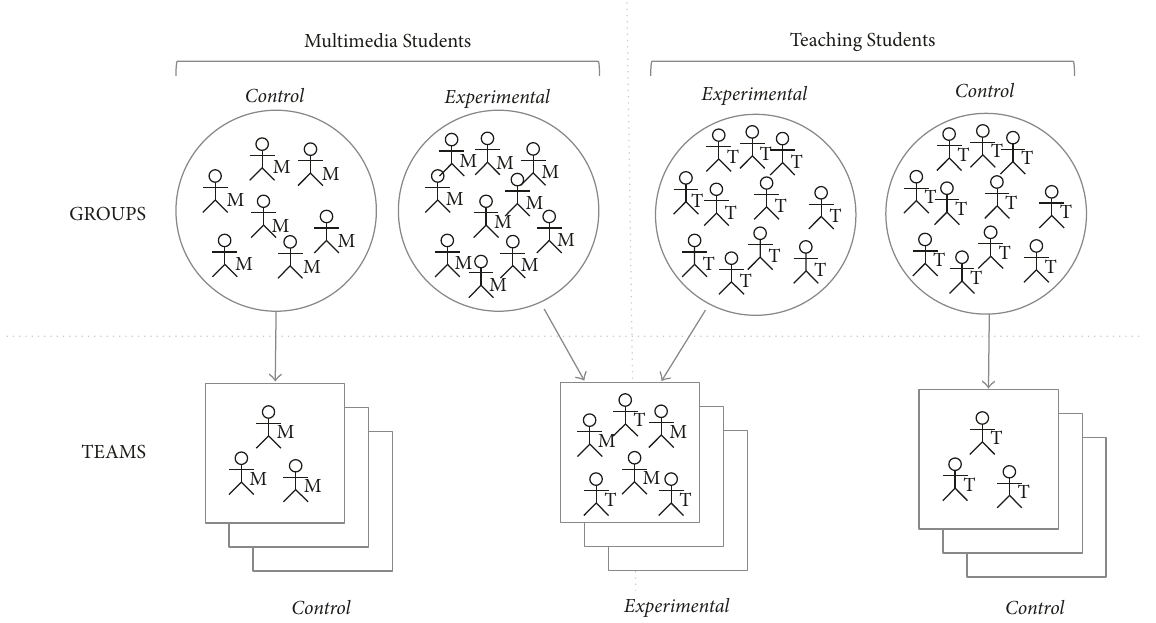
Figure 1: Distribution process for groups and teams.